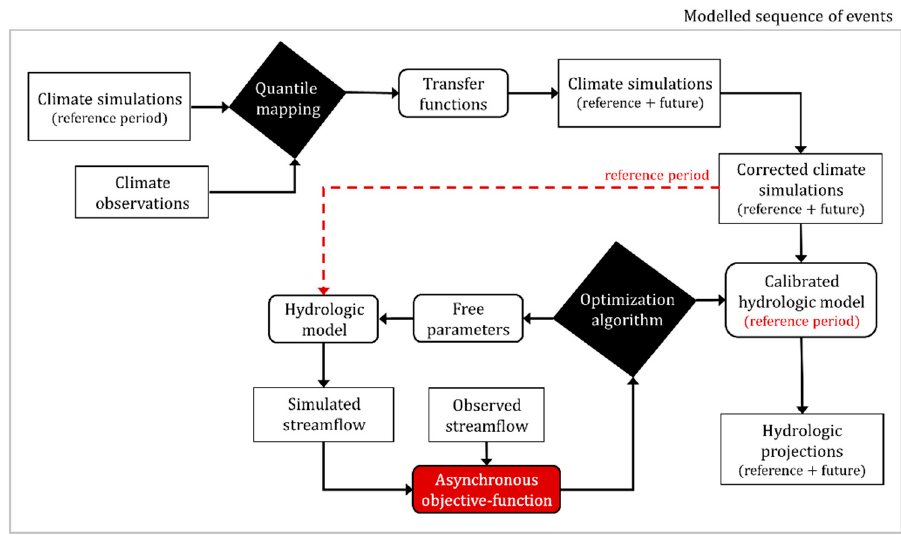
Figure 2. Alternative configuration of the hydroclimatic modeling chain.